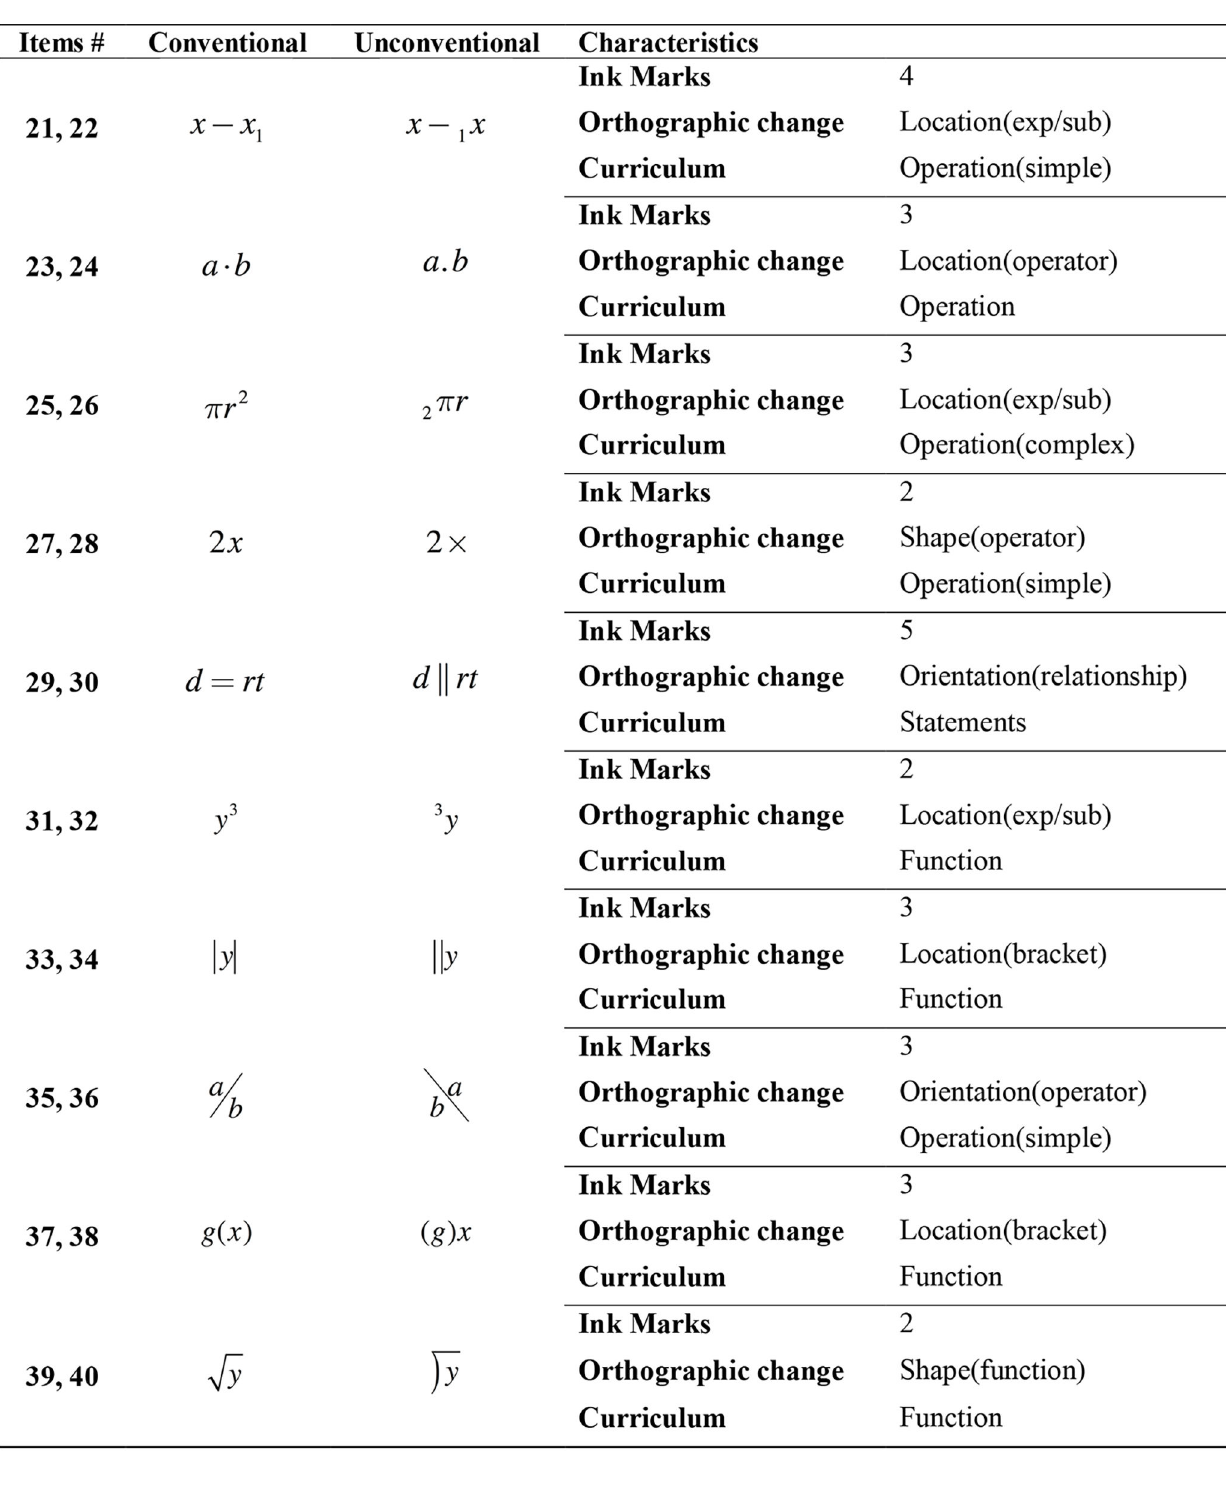
Table B.1 [continued]. Experimental Stimuli for the Symbol-Decision Task for Math